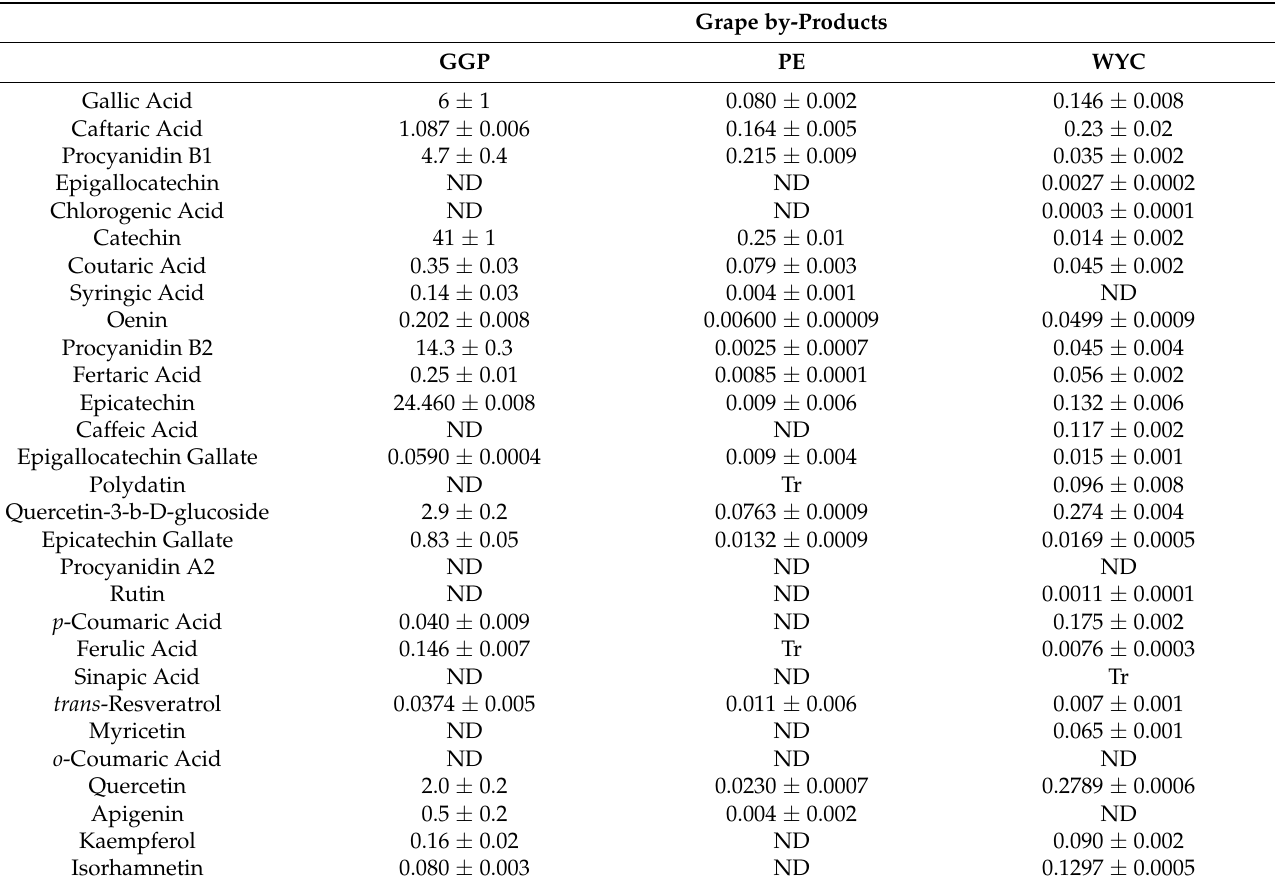
Table 6. Polyphenolic composition in grape by-products used in broilers’ diets. Grape